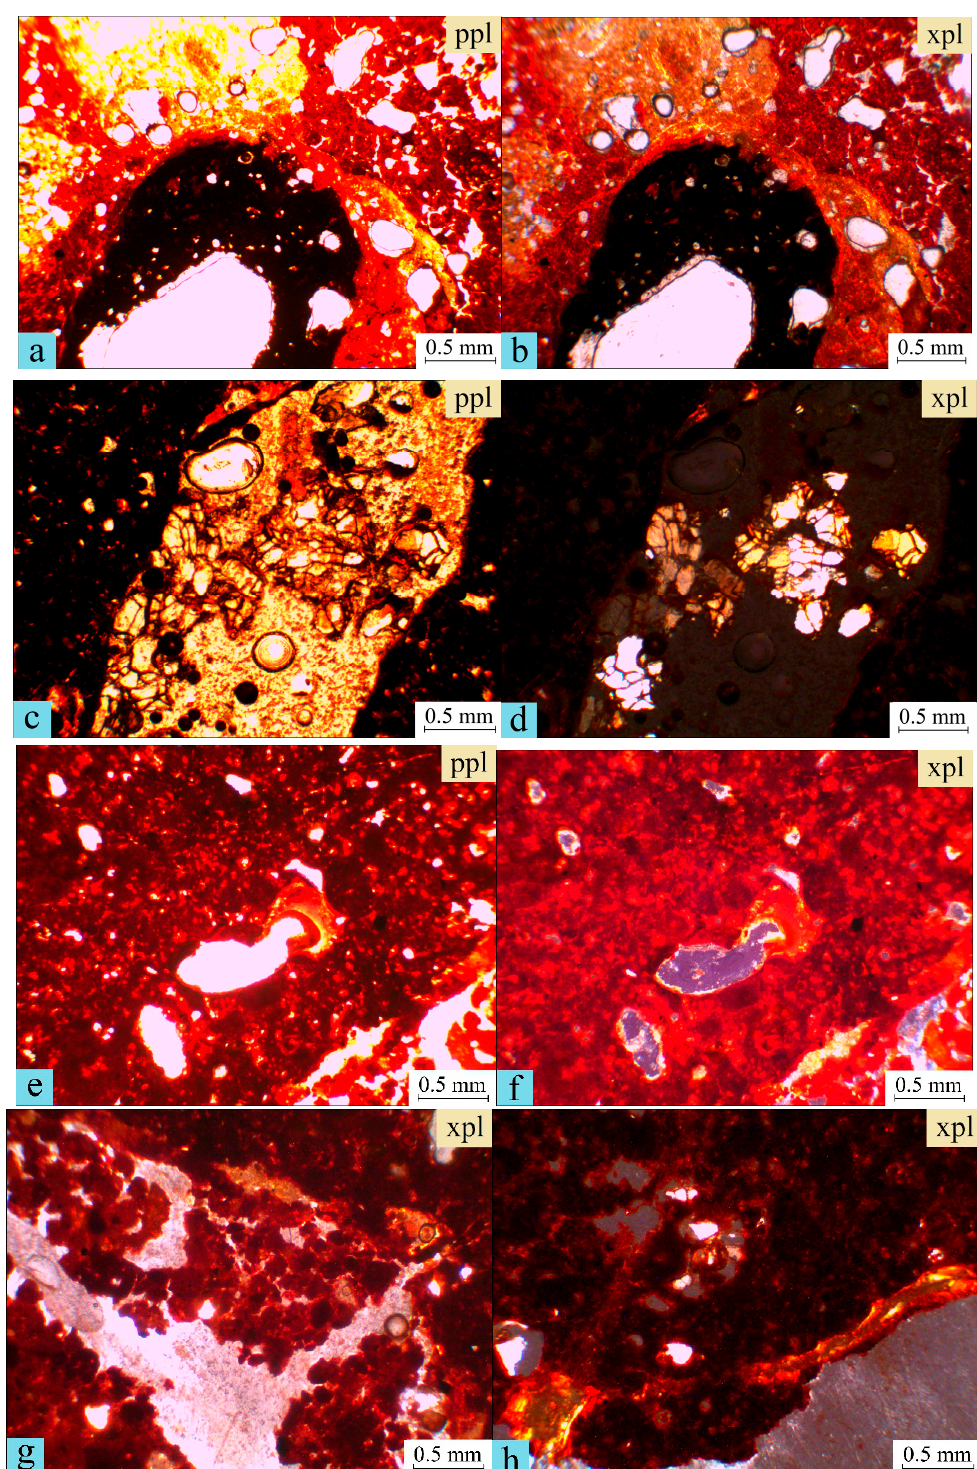
Figure 4. Pedological features in the red–yellow mottling: ( a , b ) dissolving Fe nodule surrounded by hydration halo; ( c , d ) clear, fissured quartz crystal within channel void showing continuous optical orientation and absence of clay impregnation; ( e , f ) laminated clay coating; ( g ) loose discontinuous infilling of spherical granules on faunal channel; ( h ) laminated coating probably formed on relict clod surface. ppl: plane polarized light; xpl—cross-polarized light.